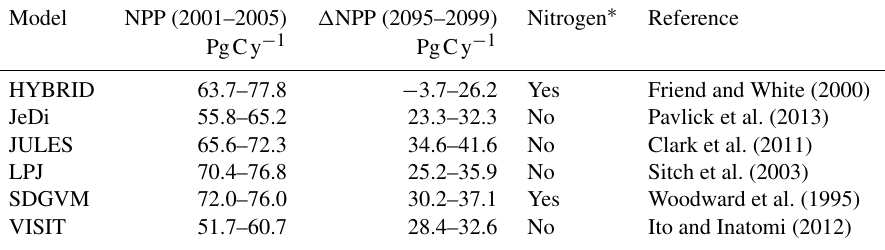
Table 1. Information about global vegetation models is used here. For each GVM,we indicate the range of values obtained while driving the model with 5